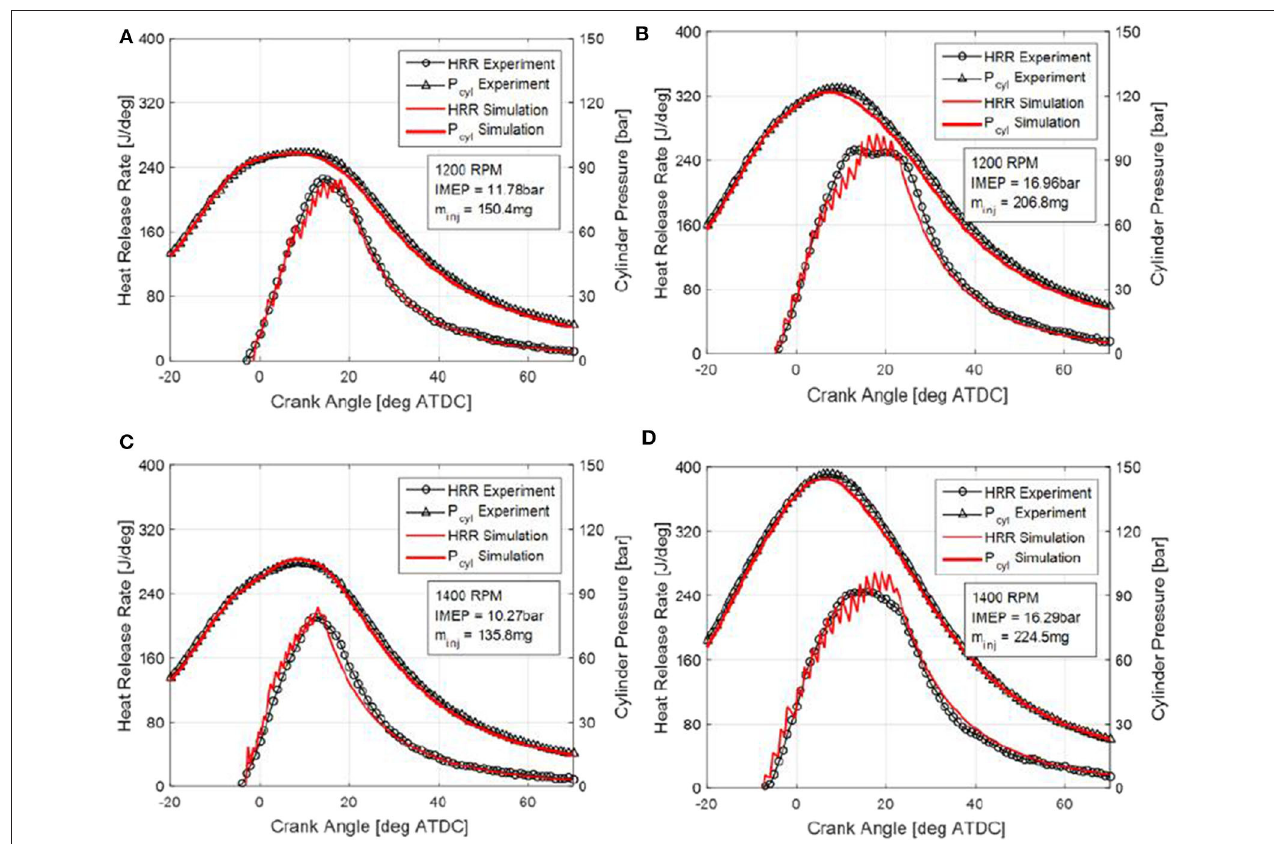
FIGURE 12 | (A–D) Validation results of heat release profile and cylinder pressure at diesel only operation conditions.